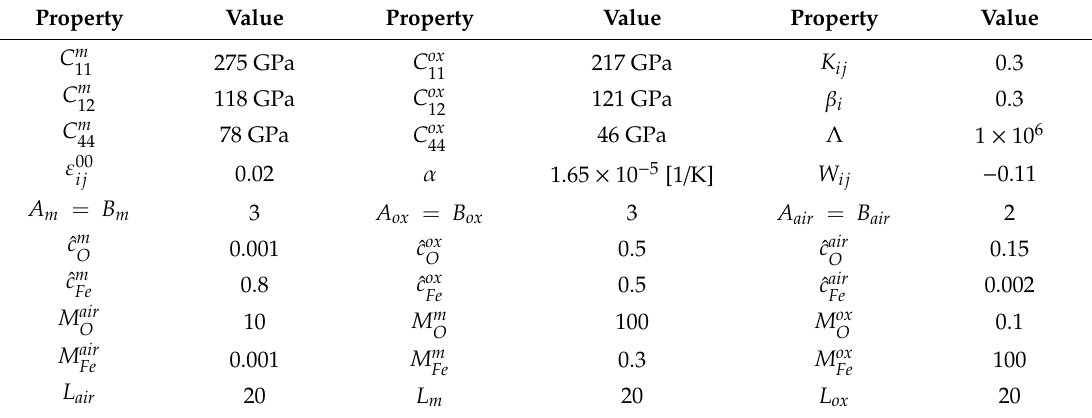
Table 1. Material properties and model parameters. Elastic constants are from [20,46], thermal expansion coe ffi cient is from [47], and ε 00 is calculated based on PBR = 1.67 for FeO and ω = 0.11 [44]. ij Property Value Property Value Property